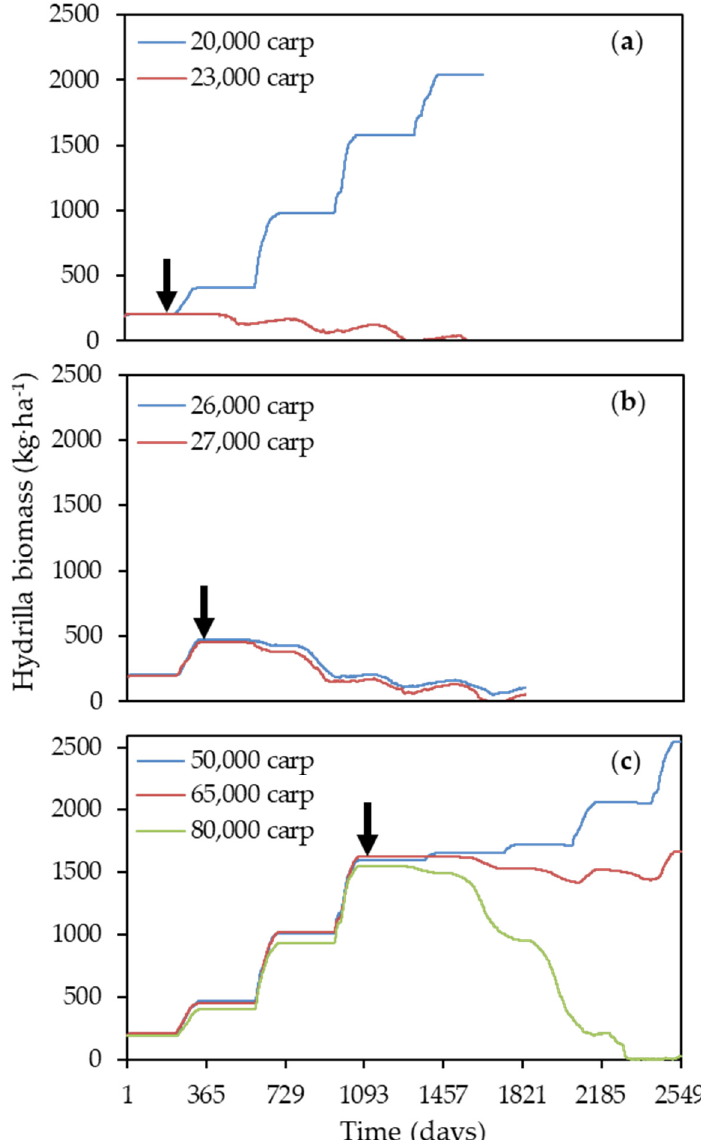
Figure 7. Number of simulated grass carp needed to eradicate Hydrilla within four years of grass carp stocking, assuming stocking occurred ( a ) six months, ( b ) one year, or ( c ) three years after invasion. Black arrows denote when grass carp were stocked.